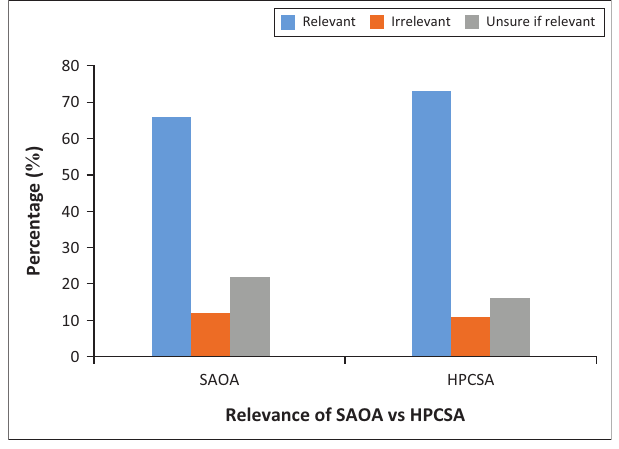
FIGURE 3: Relevance of the South African Optometric Association versus the Health Professions Council of South